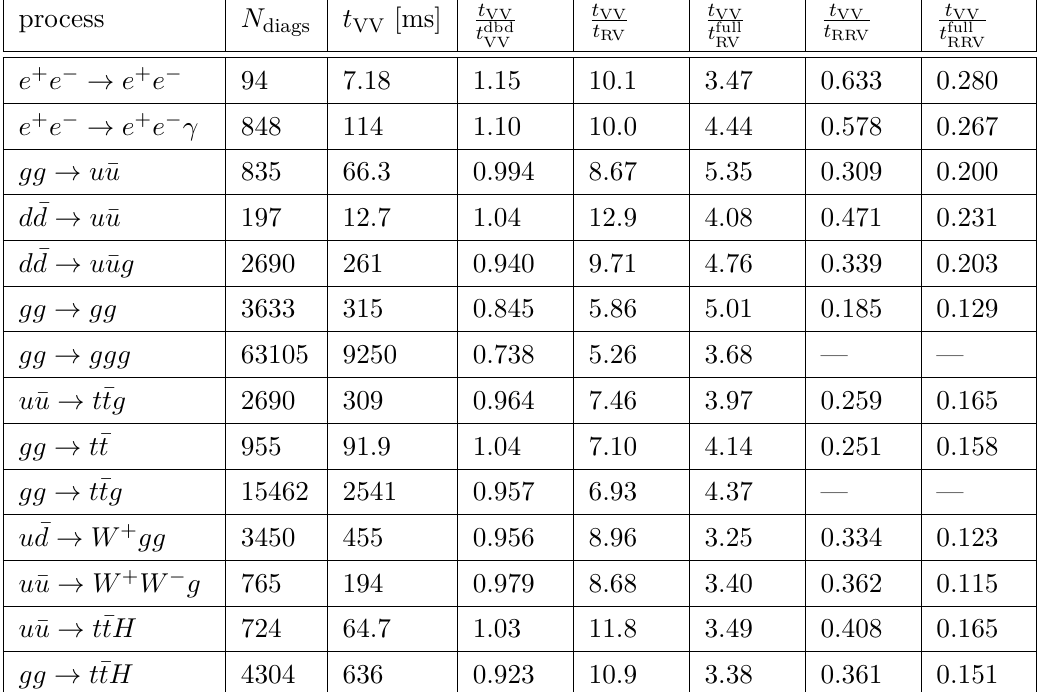
Table 4 . Virtual-virtual and real-virtual timings for the 2 → 2 and 2 → 3 processes discussed in section